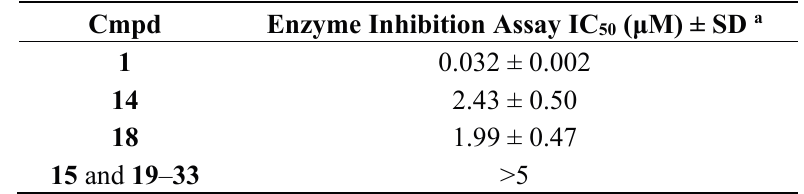
Table 6. Enzyme inhibition activities of compounds 14 , 15 , 18 – 33 .